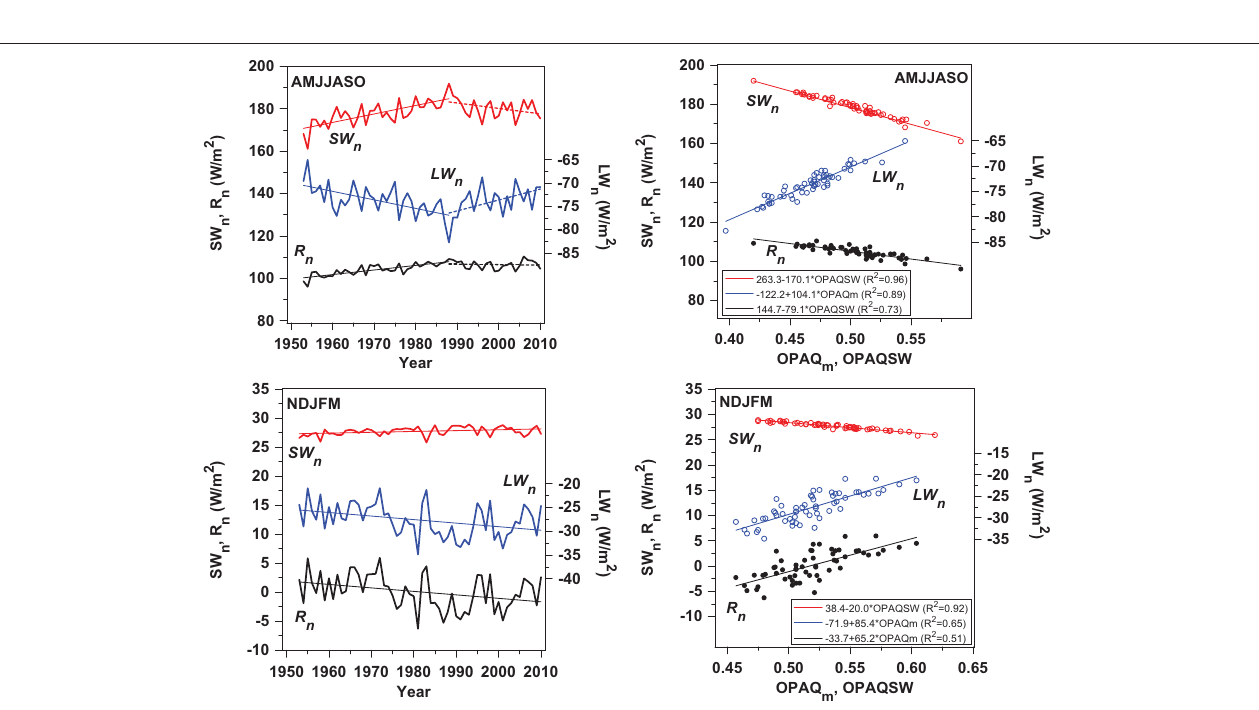
FIGURE 5 | Interannual variability of SW n , LW n , and R n for warm season (AMJJASO) and cold season (NDJFM) (left) and (right) regression of SW n and R n on OPAQSW, LW n on OPAQ m in warm season (top); SW n on OPAQSW, LW n and R n on OPAQ m in cold season (bottom).